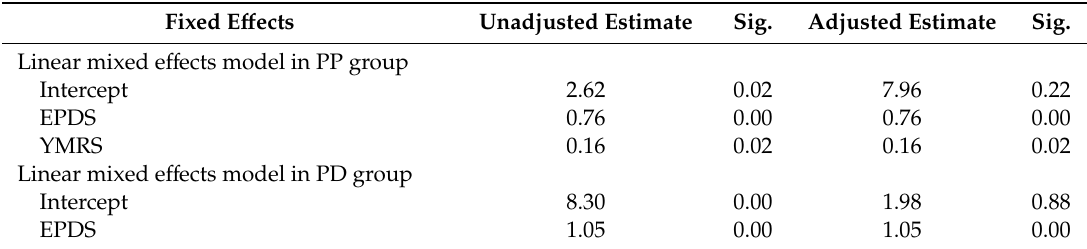
Table 2. The e ff ect of depressive (EPDS) and manic (YMRS) symptoms on mother-to-infant bonding